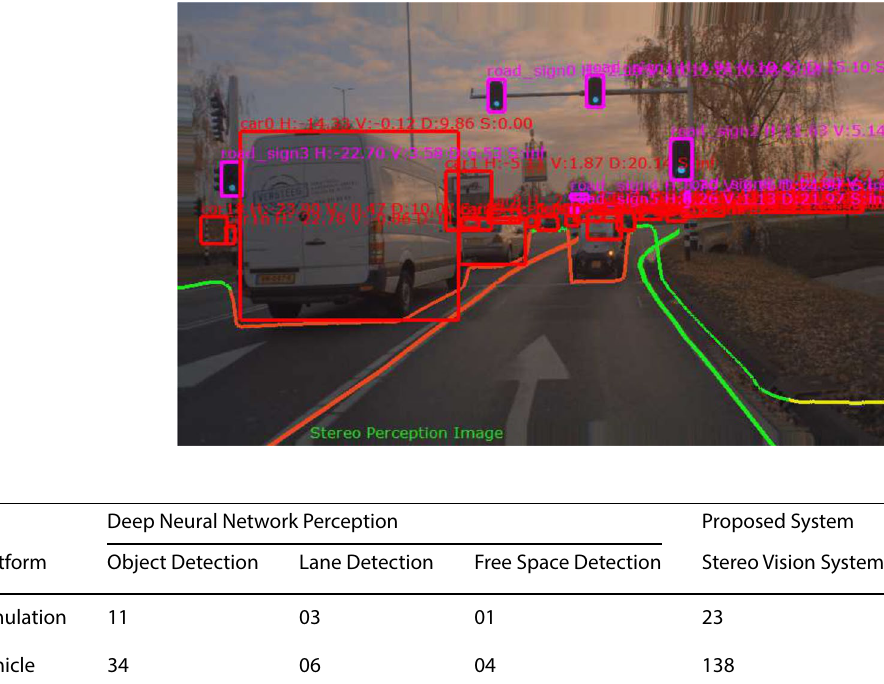
Fig. 16 Result of proposed stereo vision software